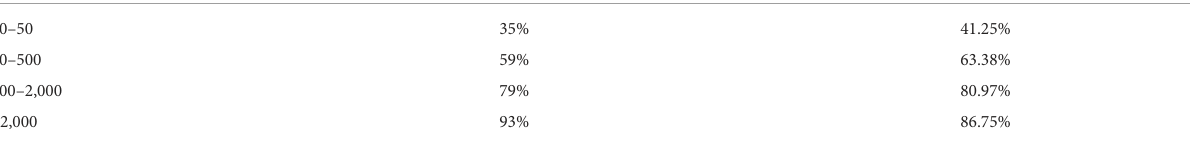
TABLE 6 Test accuracy comparison.